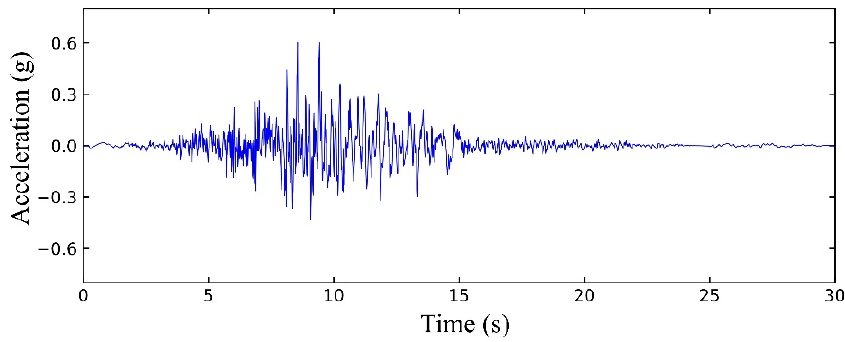
Figure 2. Acceleration time history of base input